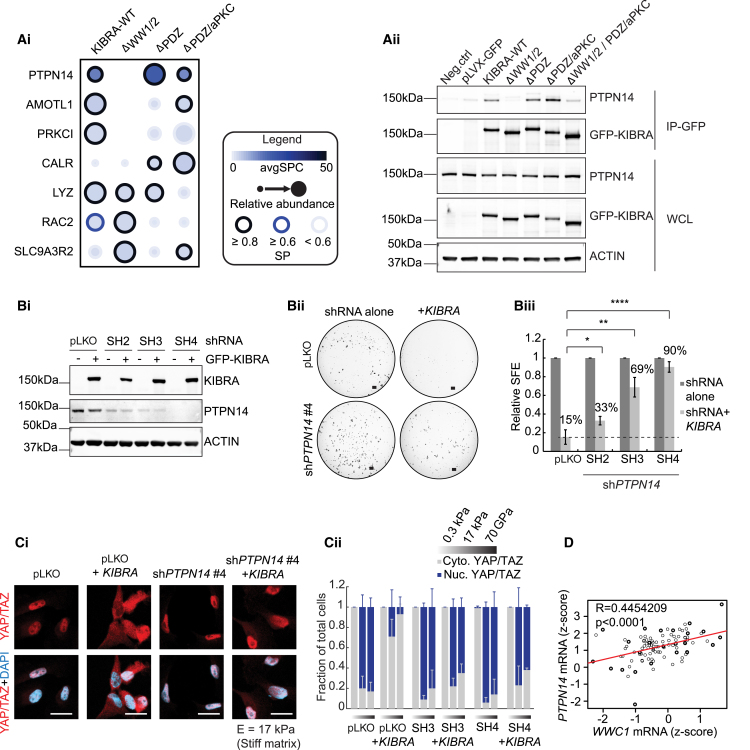
The KIBRA WW1/2 Domain Interactor PTPN14 Is Required for KIBRA-Mediated Inhibition of Tumorsphere Formation(Ai) High-confidence KIBRA-proximal proteins from BioID mass spectrometry analysis of MDA-MB-231 cells expressing WT or mutated KIBRA.(Aii) Co-immunoprecipitation of KIBRA and PTPN14 in MDA-MB-231 cells expressing wild-type or mutated KIBRA.(Bi) Western blot showing PTPN14 levels in MDA-MB-231-KIBRA cells expressing 3 PTPN14 shRNAs (SH2, SH3, and SH4) or empty vector (pLKO).(Bii) Representative images of MDA-MB-231 tumorspheres expressing pLKO or PTPN14 SH4 ± KIBRA. Scale bars, 400 μm.(Biii) SFE of MDA-MB-231 cells expressing pLKO or PTPN14 shRNA with or without KIBRA, normalized to the appropriate shRNA-alone condition (conditions seeded in triplicate, mean of 2 experiments ± SEM).(Ci) YAP/TAZ localization in MDA-MB-231 cells expressing pLKO or PTPN14 shRNA with or without KIBRA. Scale bars, 40 μm.(Cii) Quantification of YAP/TAZ nuclear to cytoplasmic ratios in MDA-MB-231 cells expressing pLKO or PTPN14 shRNA with or without KIBRA, cultured on soft (0.3 kPa) or stiff (17 kPa) matrix or collagen-coated glass coverslips (70 GPa) (n = 3 mean ± SD).(D) Pearson correlation analysis of WWC1 (KIBRA) and PTPN14 mRNA levels (Z scores) in pooled basal and claudin-low patients (TCGA data, n = 89).See also Figure S6 and Table S4.